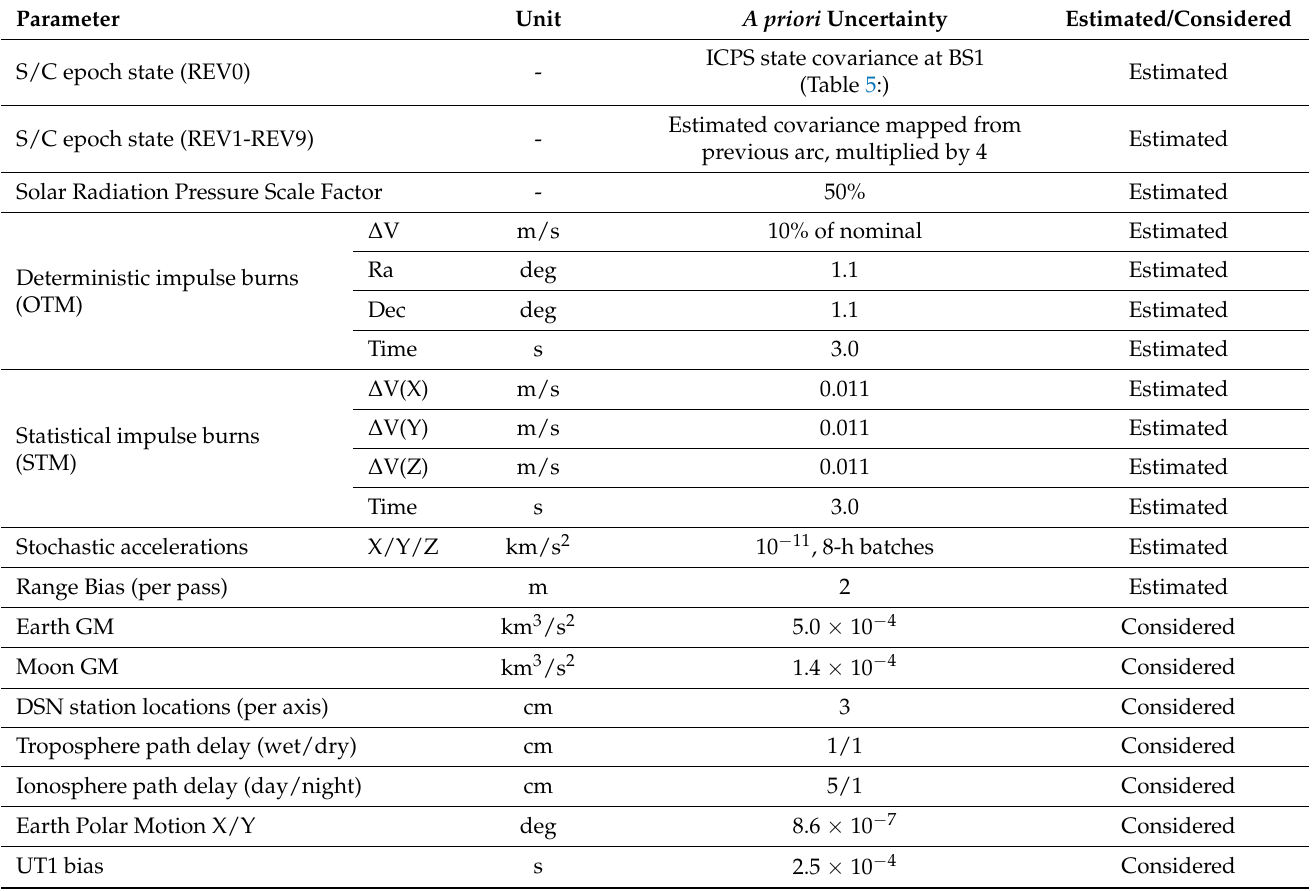
Table 7. Baseline filter setup for each OD